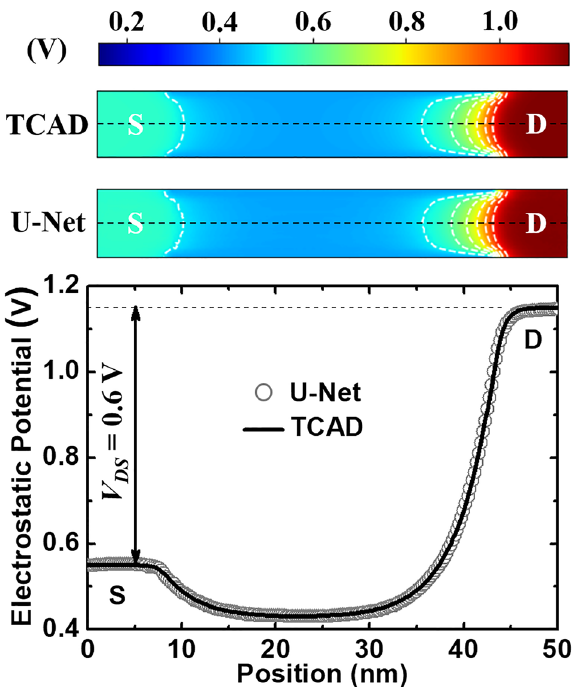
Figure 3. Comparisons between TCAD testing data and U-Net predicted results of electrostatic potential contour at V DS = 0.6 V and V GS = 0.29 V. The contour lines (white dashed) are plotted with a constant step of 0.1 V. One-dimensional (1D) profiles along the black dashed lines are showed at the bottom ( S source, D drain).